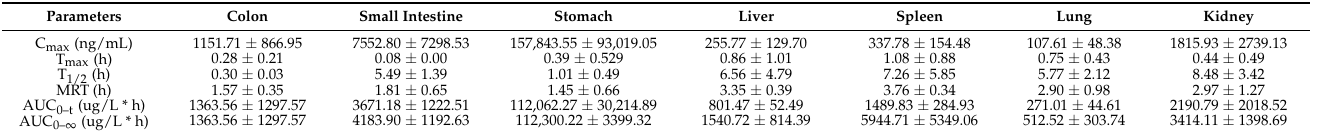
Table 3. Pharmacokinetic parameters of M10 in normal-group mouse tissues after oral administration of M10 at a dose of 50 mg/kg (mean ± SD, n =